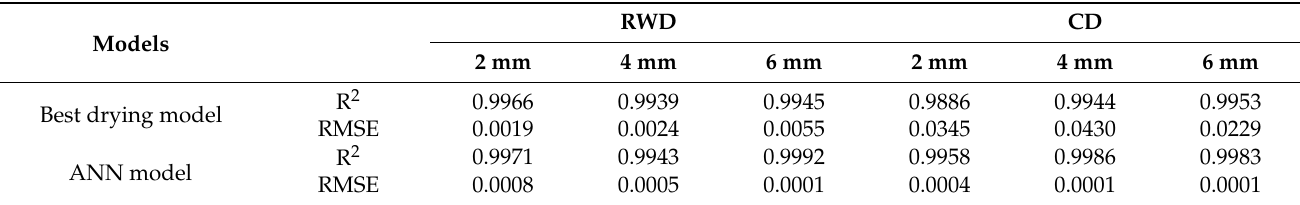
Figure 6. Model prediction through ANN and experimental data of moisture ratio of ( a ) RW dryer and ( b ) convective dryer.